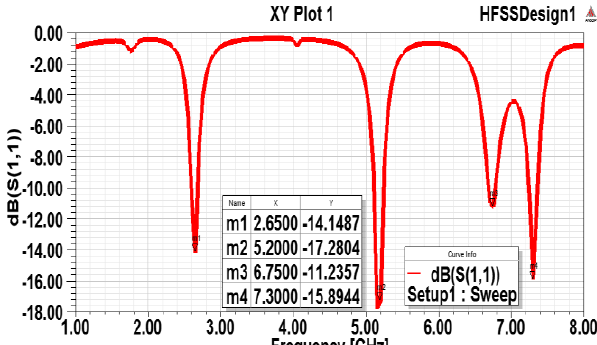
Figure 7. Simulated S 11